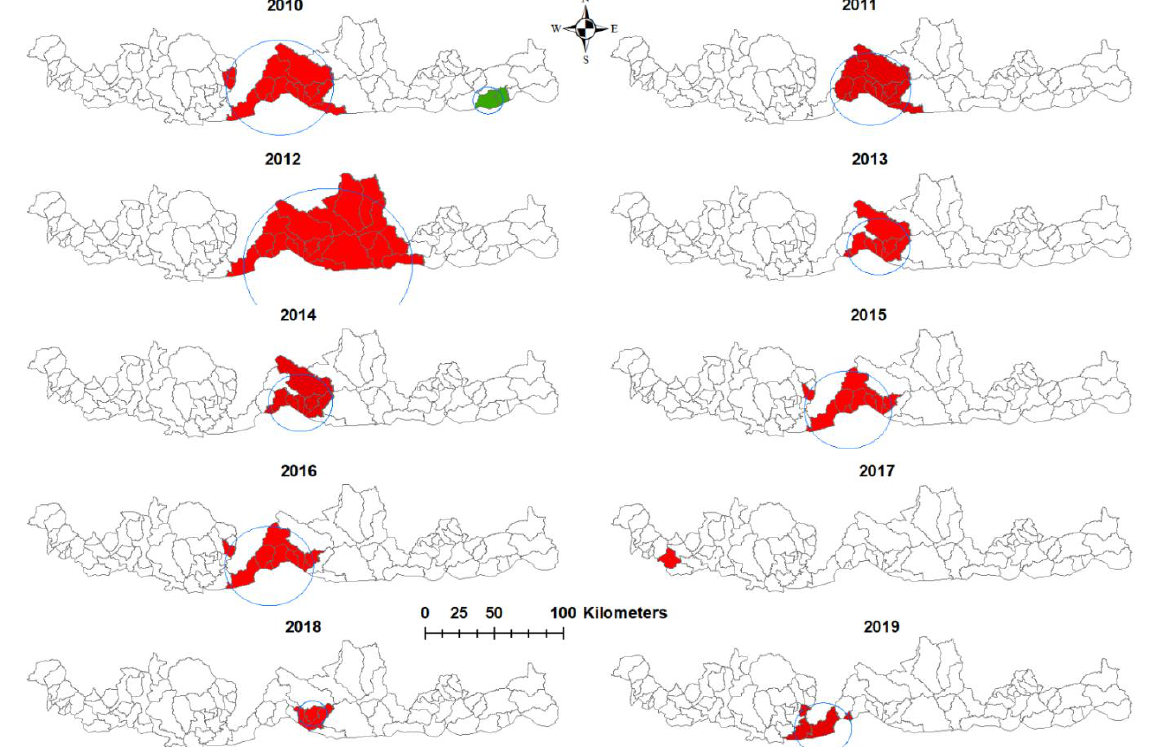
Figure 4. Spatial clusters of Plasmodium vivax malaria in Bhutan by years, 2010–2019. (Red- most likely cluster; Green- secondary